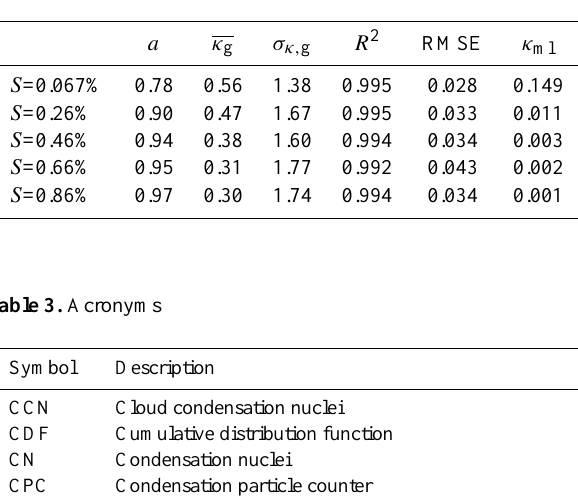
Table 2. Lognormal hygroscopicity distribution fit parameters for the CAREBeijing-2006 field campaign data (Eq. 34 and Fig. 8). The goodness of the least-squares fit is indicated by the coefficient of determination ( R 2 ) and the root mean square error (RMSE); κ ml is the lower limit of the hygroscopicity parameter range covered by measurement data.